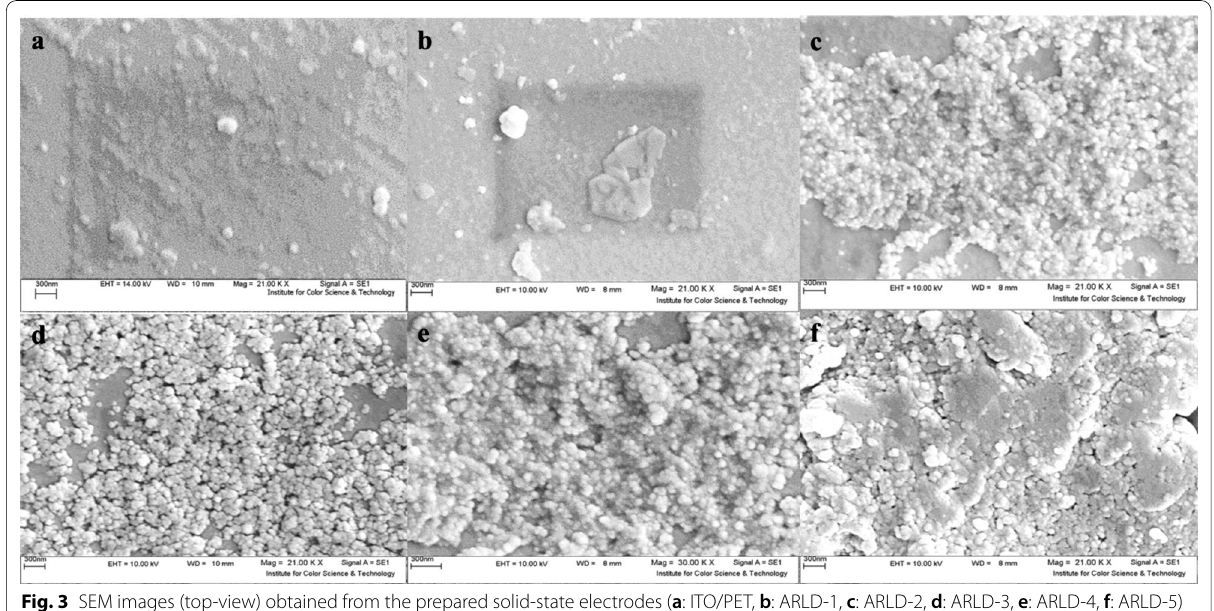
Fig. 3 SEM images (top-view) obtained from the prepared solid-state electrodes ( a : ITO/PET, b : ARLD-1, c : ARLD-2, d : ARLD-3, e : ARLD-4, f : ARLD-5)